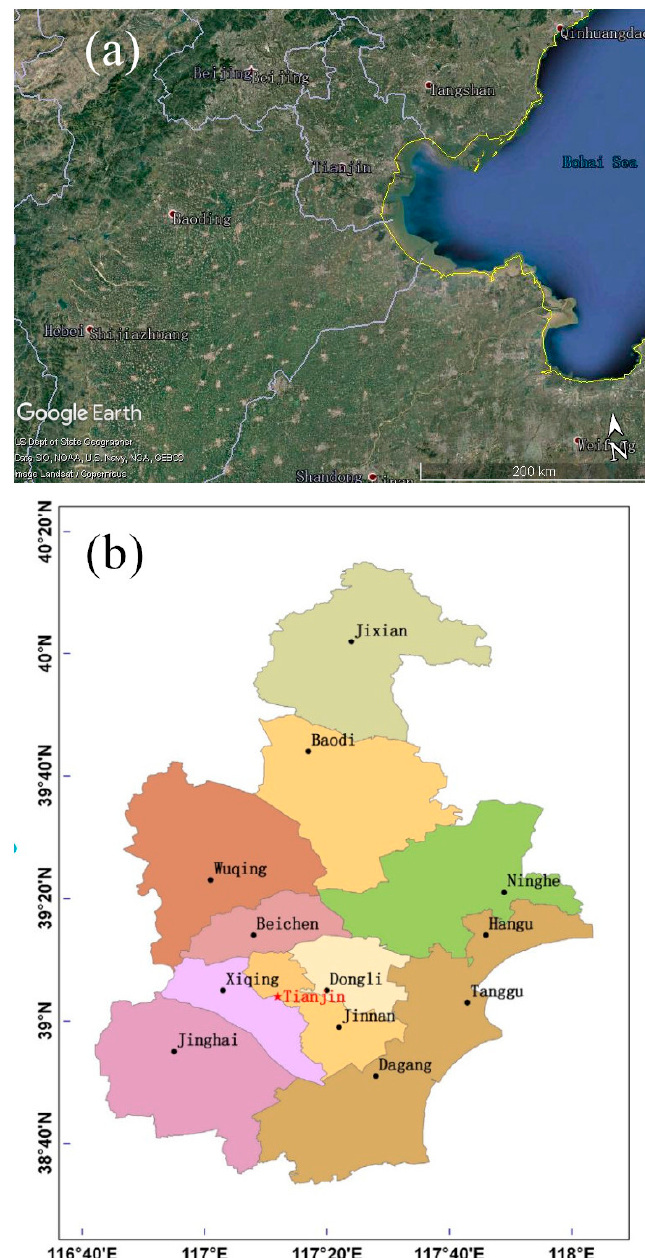
Figure 1. ( a ) Google Earth map of Tianjin and its vicinity. ( b ) The location of surface weather stations in Tianjin. Tianjin (red star) represents the location of the atmospheric boundary layer Meteorological Observation Station.